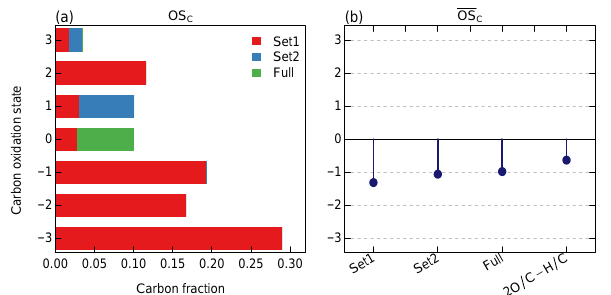
Figure 7. Distribution of carbon oxidation states and their ensem- ble estimate APIN simulation at t max SOA . Panel (a) shows distri- bution and measurable carbon atoms with same color scheme 5. Panel (b) shows various estimates of OS C (b) for the mixture using different FG sets (Sect. 2.3). 2O / C–H / C is a common approxima- tion used by elemental analysis and is included for